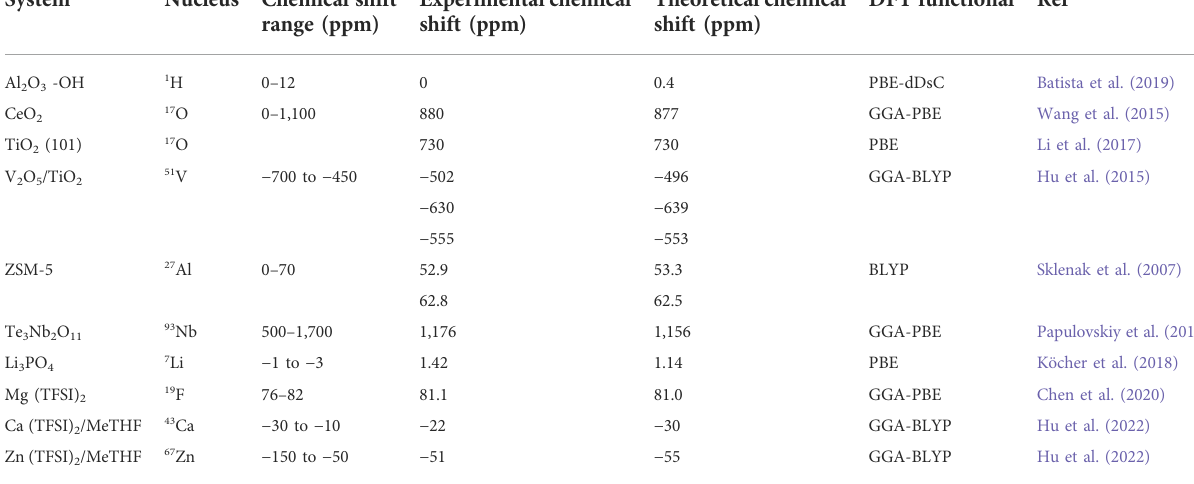
TABLE 1 Selected examples of different nuclei with comparison of experimental and calculated chemical shifts.